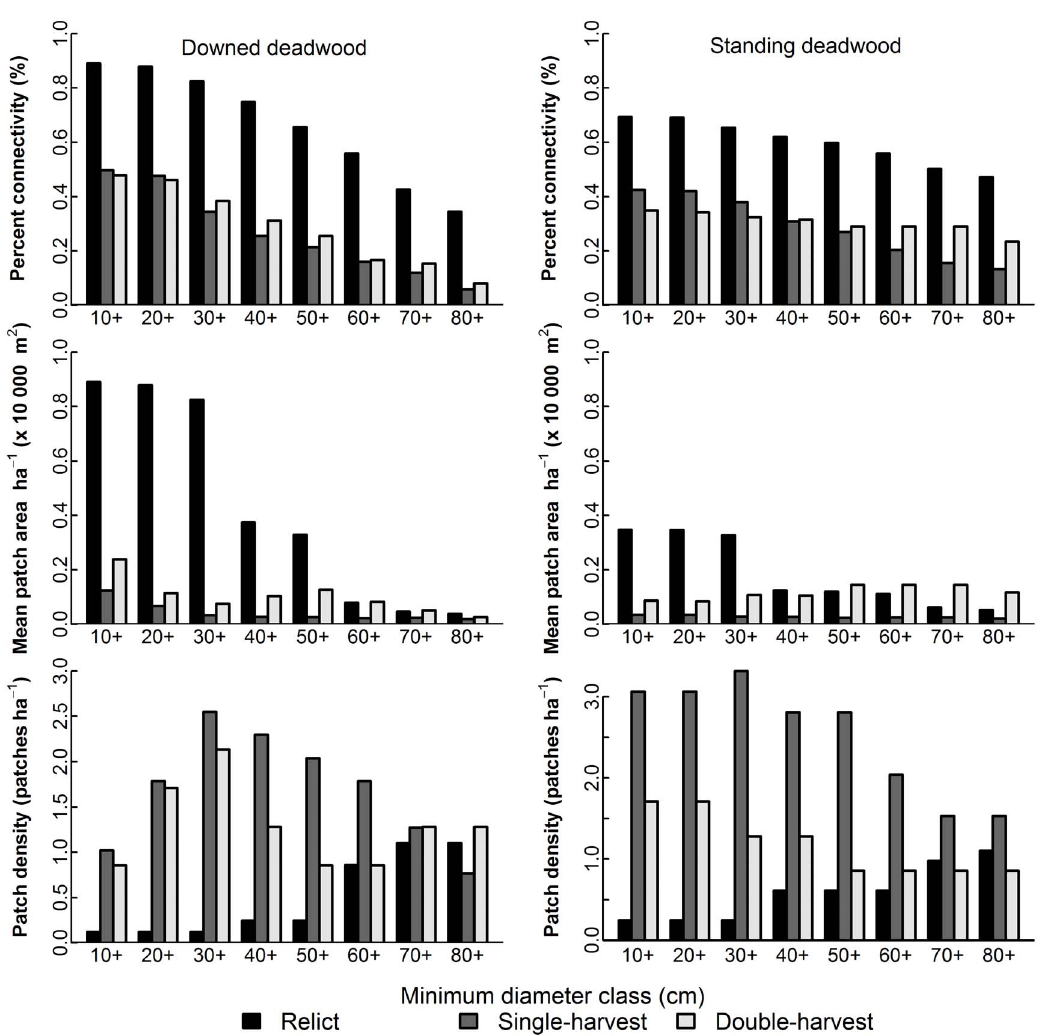
Figure 3. Coarse woody debris connectivity and patch-level summaries. Percent of all plots connected based upon presence of CWD (top row), mean patch area ha 2 1 (middle row), and number of patches ha 2 1 (bottom row) by 10 cm diameter classes for relict, single-harvest, and double- harvests stands. Downed deadwood (left column) diameter was based on large end diameter, and we used diameter at 1.37 m (DBH) for standing deadwood (right column); each diameter class indicates pieces of indicated size and larger were included in the analysis.